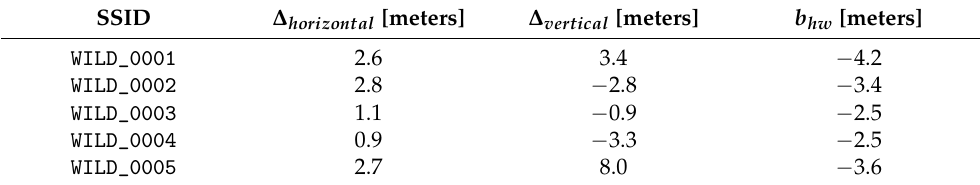
Table 4. Results with RTT measurements tagged with the Android Position . Horizontal and vertical position deviations relative to the reference WAP positions and computed WAP hardware bias.